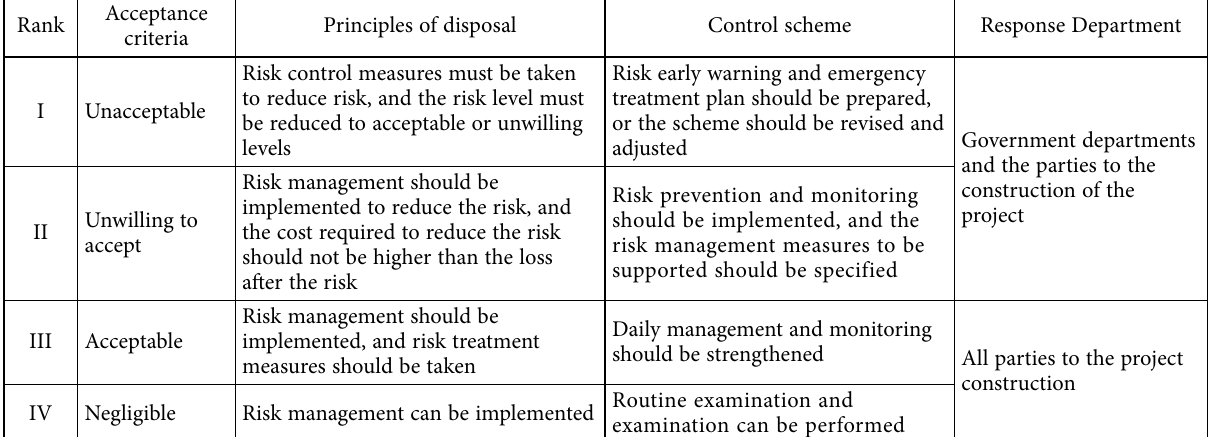
Table 4. Risk management principle table